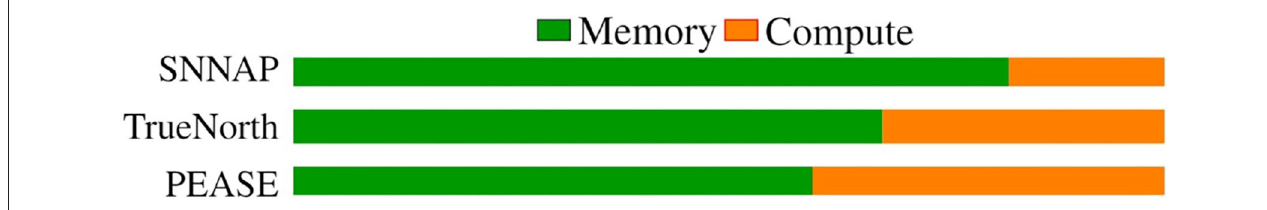
FIGURE 2 | Ratio of memory to compute energy on PEASE, TrueNorth, and SNNAP.